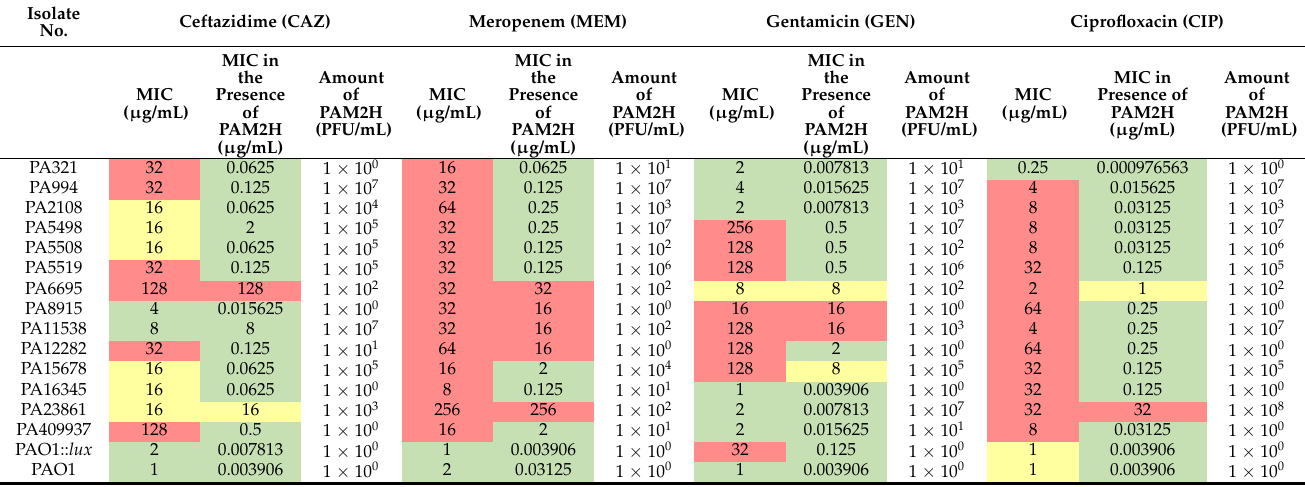
(Table 2). In the presence of the PAM2H cocktail, the number of strains susceptible to CAZ increased by 63% and the number of strains susceptible to MEM, GEN, and CIP increased by 56%, 31%, and 81%, respectively. These data suggest that including PAM2H in combination treatment with an antibiotic that the bacterial target is resistant to could result in efficacious outcomes by re-sensitizing the bacterial strain to the antibiotic. Table 3. Fractional inhibitory concentrations of antibiotics CAZ, MEM, GEN, and CIP in the presence of the PAM2H phage